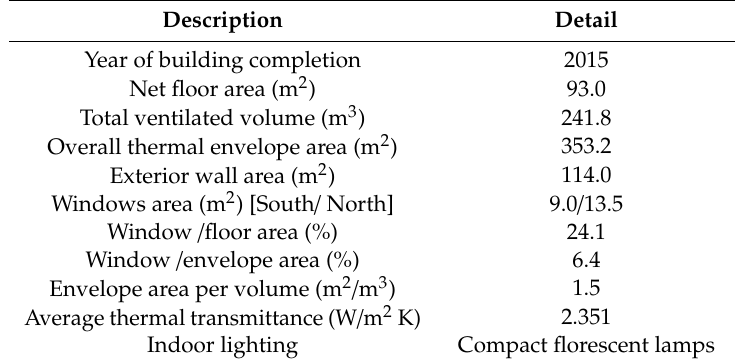
Table 2. Key architectural and design characteristics of the case-study single-family